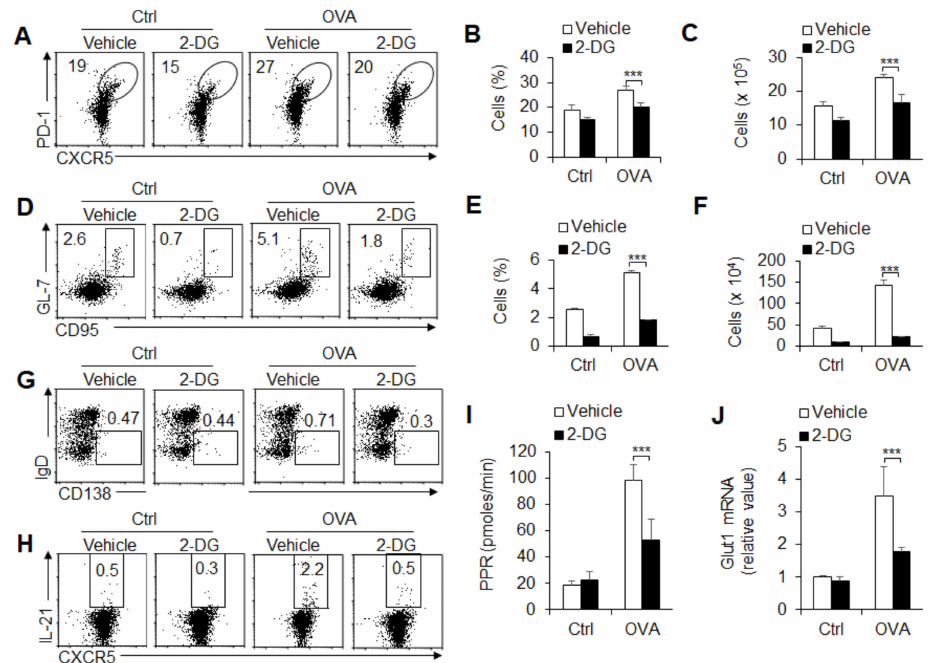
Figure 4. Blocking glycolysis inhibits T FH cell di ff erentiation stimulated by foreign antigens. WT mice underwent intraperitoneal immunization with OVA plus LPS in alum and in the presence of PBS (vehicle) or 2-DG (200 mg / kg / day) i.p. at 8 days, and mouse spleens were isolated for analysis. ( A – C ) Flow cytometry of T FH cells in spleens in A. The frequency and the number of T FH cells are shown in B–C. ( D – F ) Flow cytometry of GC B cells in spleens in D. The frequency and the number of GC B cell are shown in E and F. ( G , H ) Flow cytometry analysis of plasma cells ( G ) and IL-21 + T FH cells (H) in spleens. ( I ) PPR was analyzed as a readout for glycolysis in T FH cells sorted from splenocytes. ( J ) Glut1 mRNA expression was analyzed by real-time PCR in T FH cells sorted from splenocytes. Data are representative of four individual experiments (n = 3–5 mice per group). *** p < 0.001, compared with the indicated